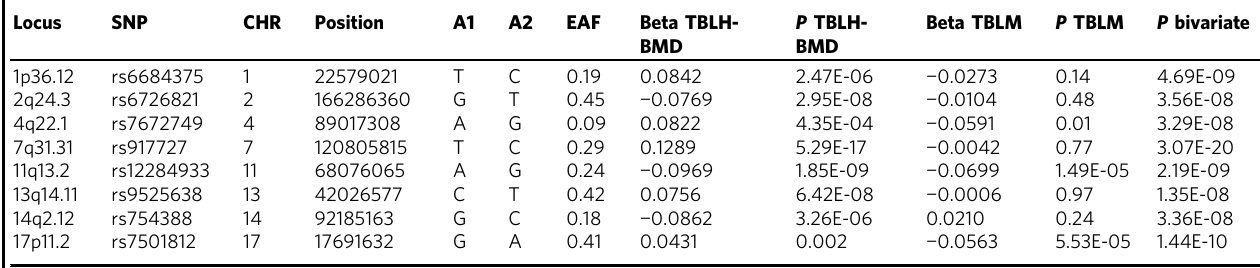
Table 3 Lead SNPs for the eight bivariate association signal with TBLH-BMD and TB-LM Locus